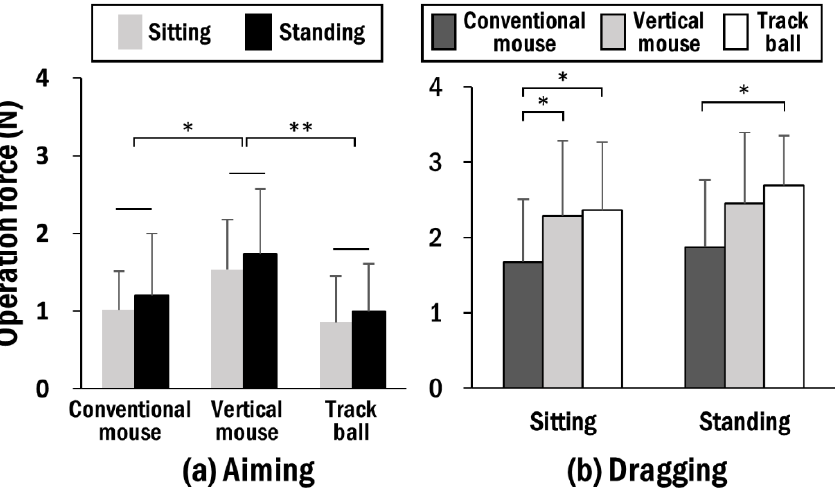
Figure 4. Average operation force ( a ) during aiming tasks by pointing device for working posture and ( b ) during dragging tasks by working posture for pointing devices. Asterisks denote a significant difference between pointing devices (* p < 0.05; ** p < 0.01).